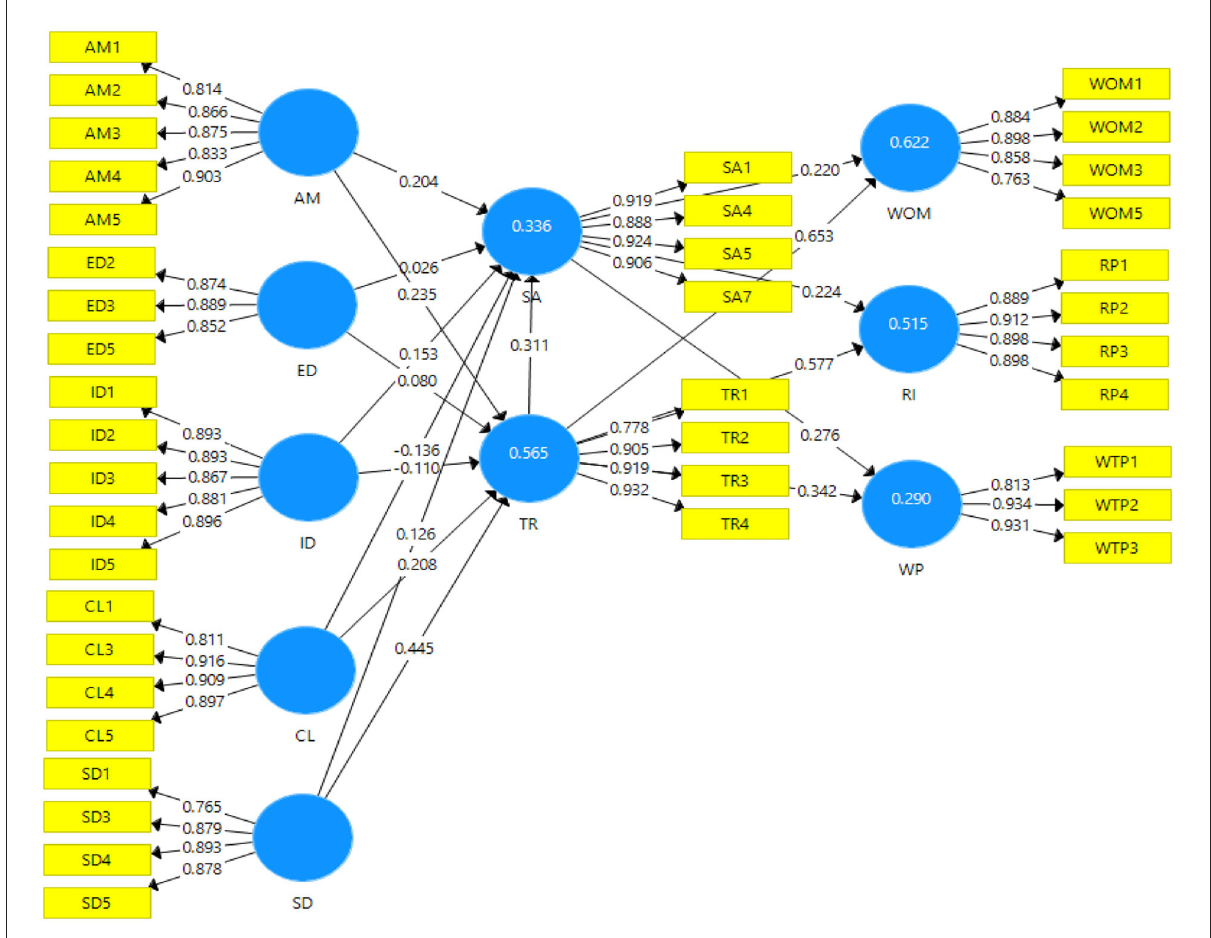
FIGURE2 Measurement